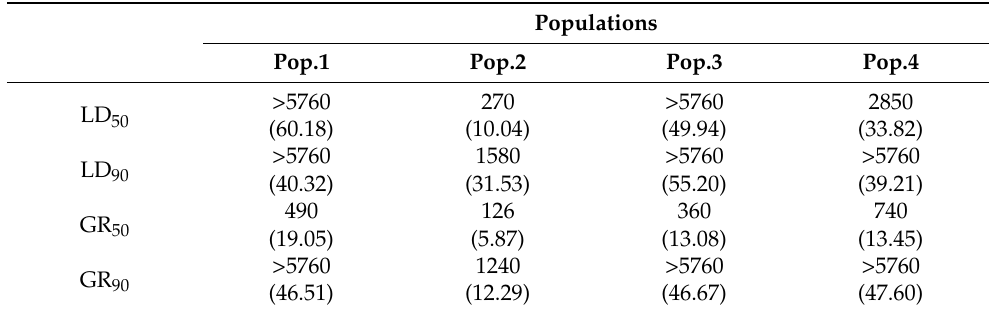
Figure 1. Fresh weight of Lolium spp. populations expressed as percentage (%) of the untreated control for different glyphosate rates at 4 weeks after treatment (WAT). Red line indicates the 50% of fresh weight. Populations 1, 3 and 4 were resistant to glyphosate whereas population 2 was the susceptible one. Table 3. LD 50 , LD 90 , GR 50 , GR 90 values (g ae ha − 1 ) for the studied populations. Standard errors are given in parentheses.